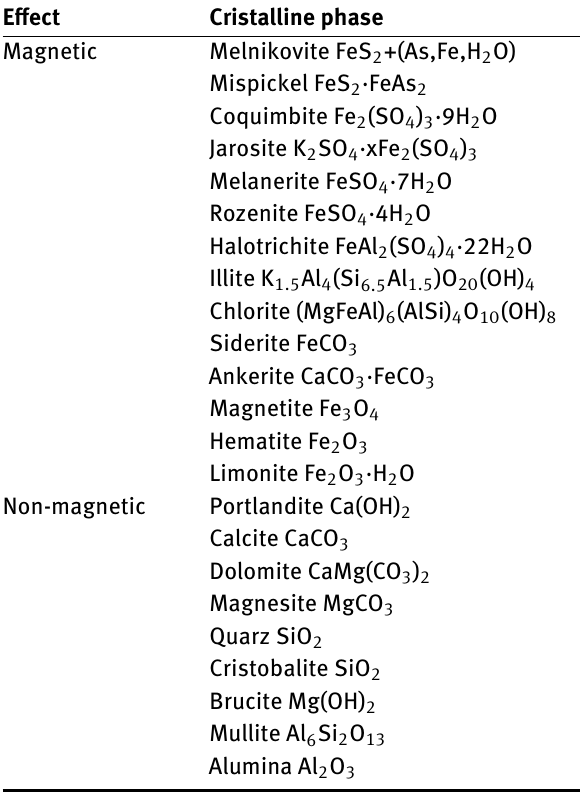
Table 4: The presence of crystalline phases and their effect on the magnetic properties of the cenospheres [1, 10, 11, 38].